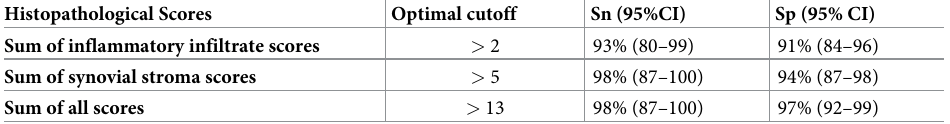
Table 4. Optimal cut-off points, based on the Younden’s index, for summed scores in each category of histopatho- logical grading of synovitis between OA and control dogs. Histopathological